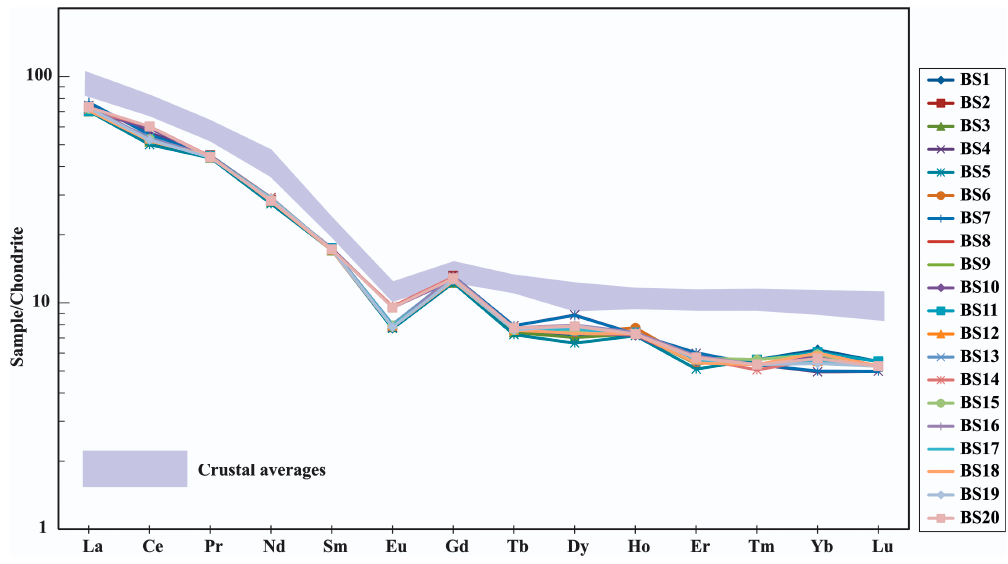
Figure 5. Chondrite ‐ normalized REE pattern for the Brahmaputra River sediments. Chondrite ‐ normalized values are from Taylor and MacLennan [30], while the grey field indicates the crustal average ranges from UCC and PAAS. Chondrite/sample values are given in ppm.